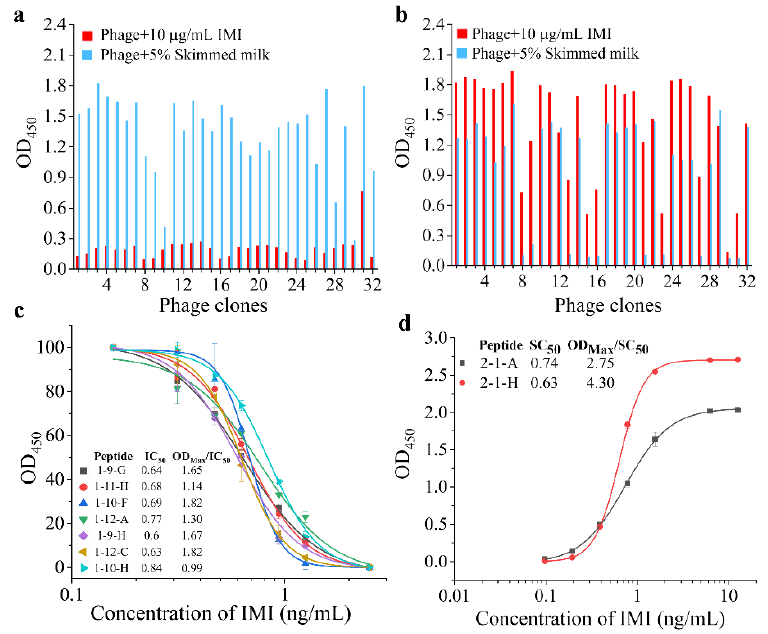
Figure 1. Panning results. ( a ) The screen of peptidomimetics. ( b ) The screen of anti-immunocomplex peptides. ( c ) Dose-response curve of different peptidomimetics. ( d ) Dose-response curve of different anti-immunocomplex peptides. Table 1. Sequence of isolated peptidomimetics and anti-immunocomplex peptides.